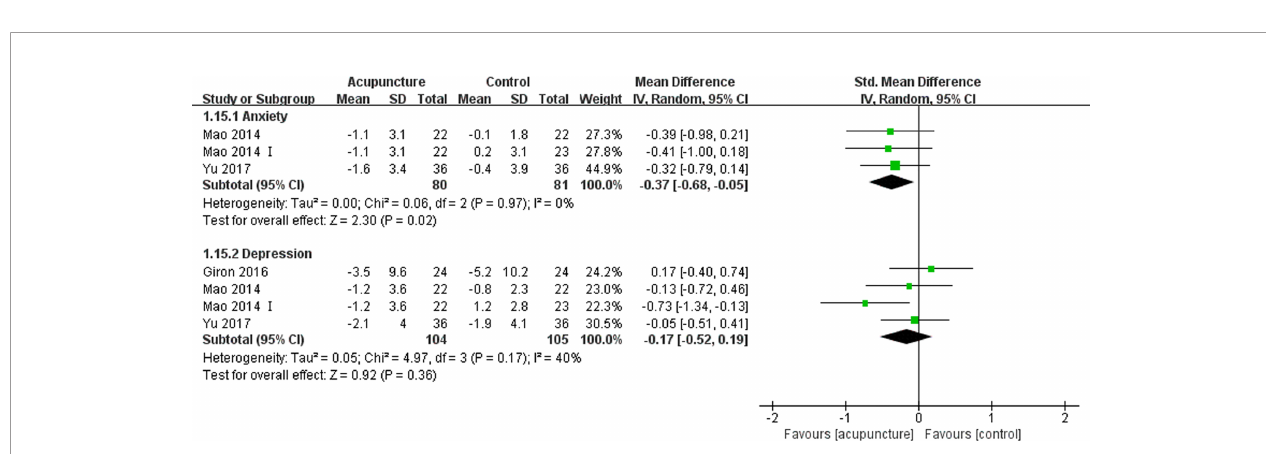
FIGURE 5 | Forest plot of sleep disturbances in BC patients treated with acupuncture and control. (A) the changes in mean scores of sleep disturbances from the bassline to end of treatment; (B) Number of patients with sleep disturbance at the end of treatment. IV, inverse variance; CI, Con fi dence Interval. The Roman numerals “ I ” followed the study ID represented the comparison of acupuncture versus no intervention in the study which had three arms.